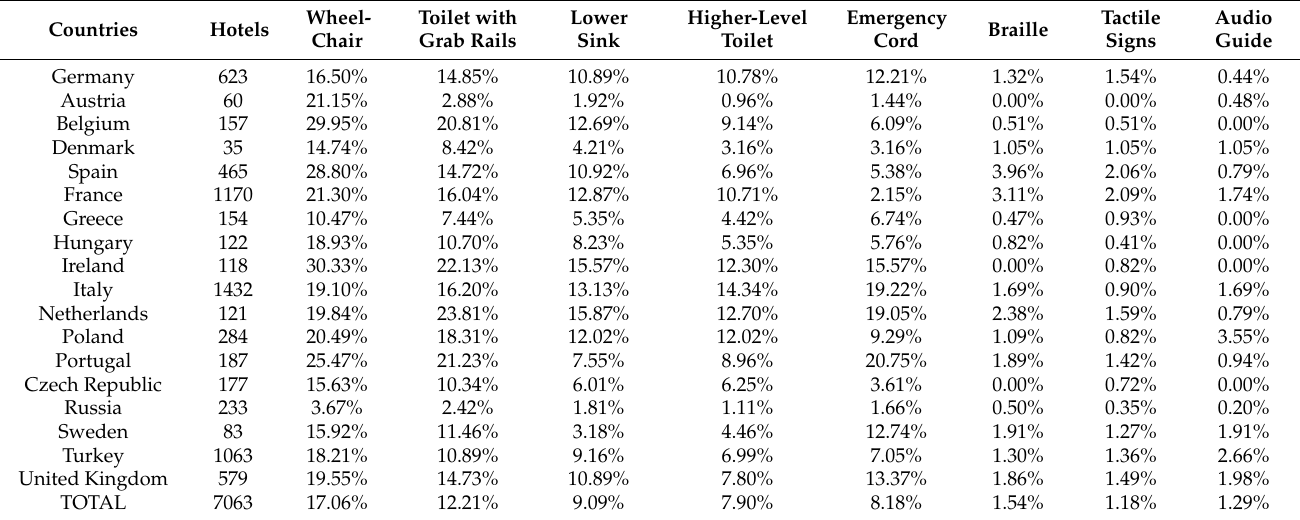
Table 6. Distribution of the accessible installations for the countries in EUR.